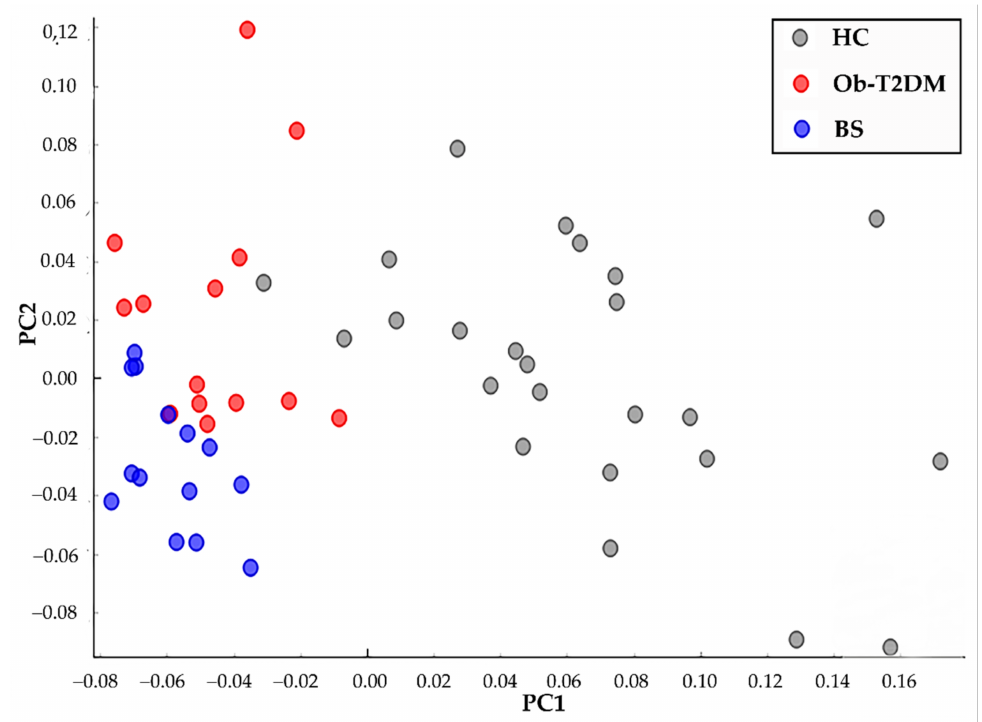
Figure 6. PCA analysis of Raman spectra. Grey dots correspond to the 23 spectra of the health control patients [HC; n = 23], whereas the red and blue correspond to the 14 spectra of the obese type 2 dia- betes mellitus patients [Ob-T2DM; n = 14] before and after bariatric surgery [BS; n = 14],